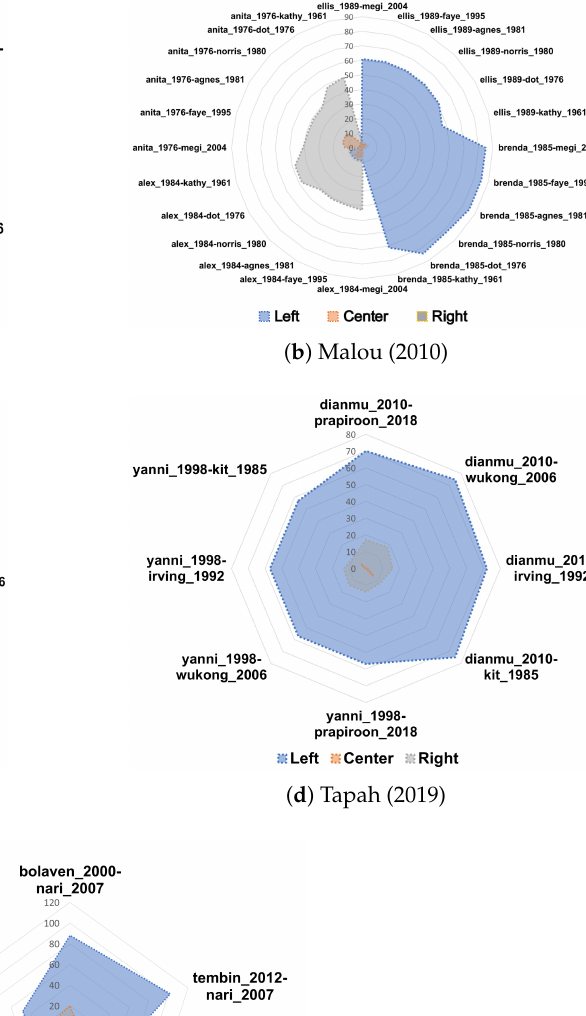
Figure 9b represents the track prediction of typhoon Malou 2010 for the zonal compo- nent. The values of predictions starting from sequence 20 are constant. On the other hand, several predictions from other members start to be constant in the next sequence. The